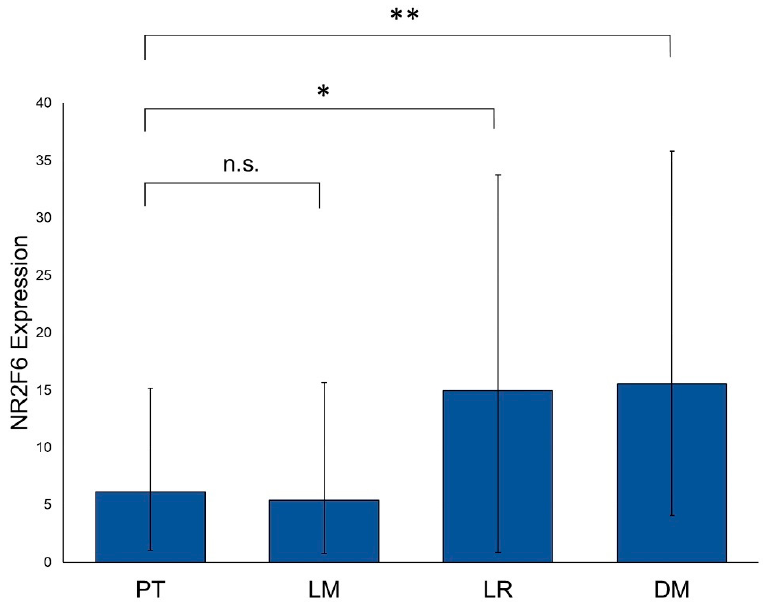
Figure 2. NR2F6 expression in primary tumors, metastases, and local recurrences. HNSCC tissue samples of PTs ( n = 330), LMs ( n = 127), LRs ( n = 62), and DMs ( n = 21) were assessed for their NR2F6 expression levels. NR2F6 expression in PTs is significantly lower than in LRs (Mann–Whitney test, p = 0.014) and DMs (Mann–Whitney test, p = 0.005). (* p ≤ 0.05; ** p ≤ 0.01; n.s. = not significant).